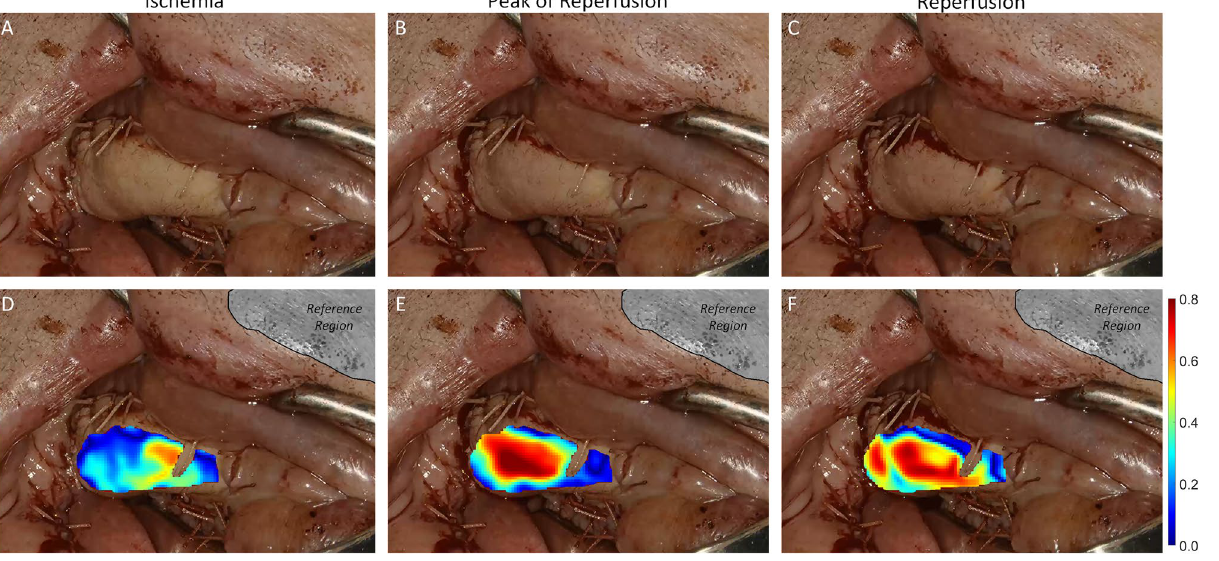
Figure 2. Visualization of local perfusion analysis. The third recording of #7 at three different time points (column-wise from left to right): Ischemia ( t = 53 s), Peak of Reperfusion ( t = 78 s), and during reperfusion ( t = 137 s). ( A – C ) show the standard RGB view. ( D – F ) show the same images augmented with local correlation analysis showing the local perfusion relationship between flap and reference region (gray). The local correlation strength is color-coded with the color bar on the